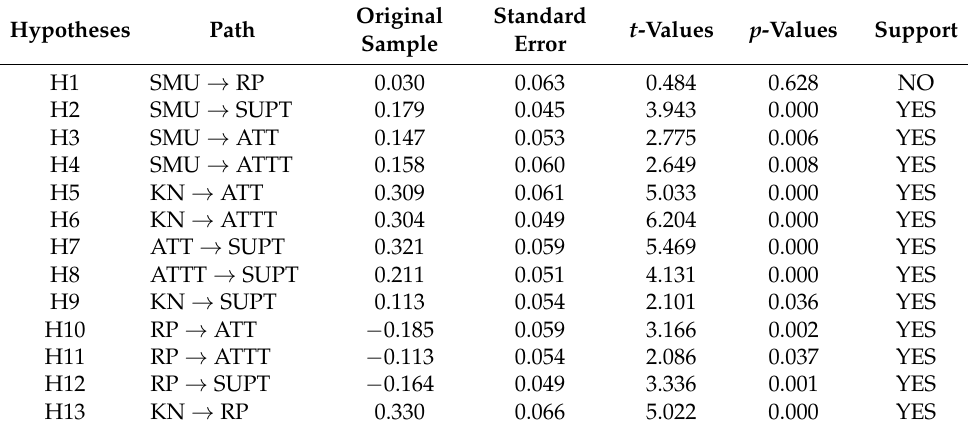
Table 5. Results of structural model.